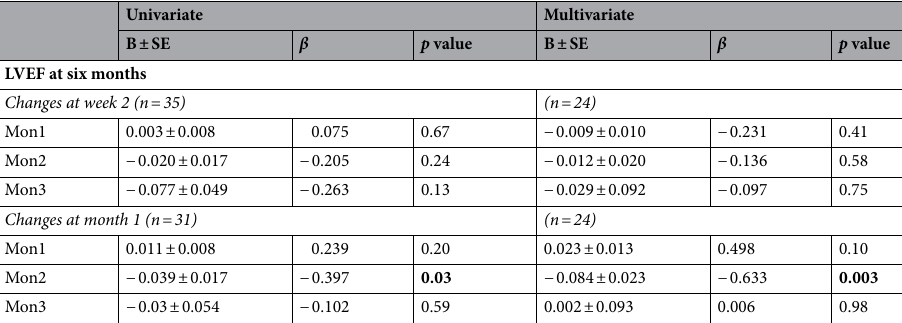
Table 2. Predictive value of changes of monocyte subsets for left ventricular ejection fraction at six months and changes in LVEF from baseline. B: Regression coefficient; SE: Standard error; LVEF: Left ventricular ejection fraction; β : adjusted regression coefficient. Multivariate analyses were performed using age, sex, maximal troponin T levels, estimated glomerular filtration rate, history of diabetes and smoking and monocyte subset counts. Significant values are in